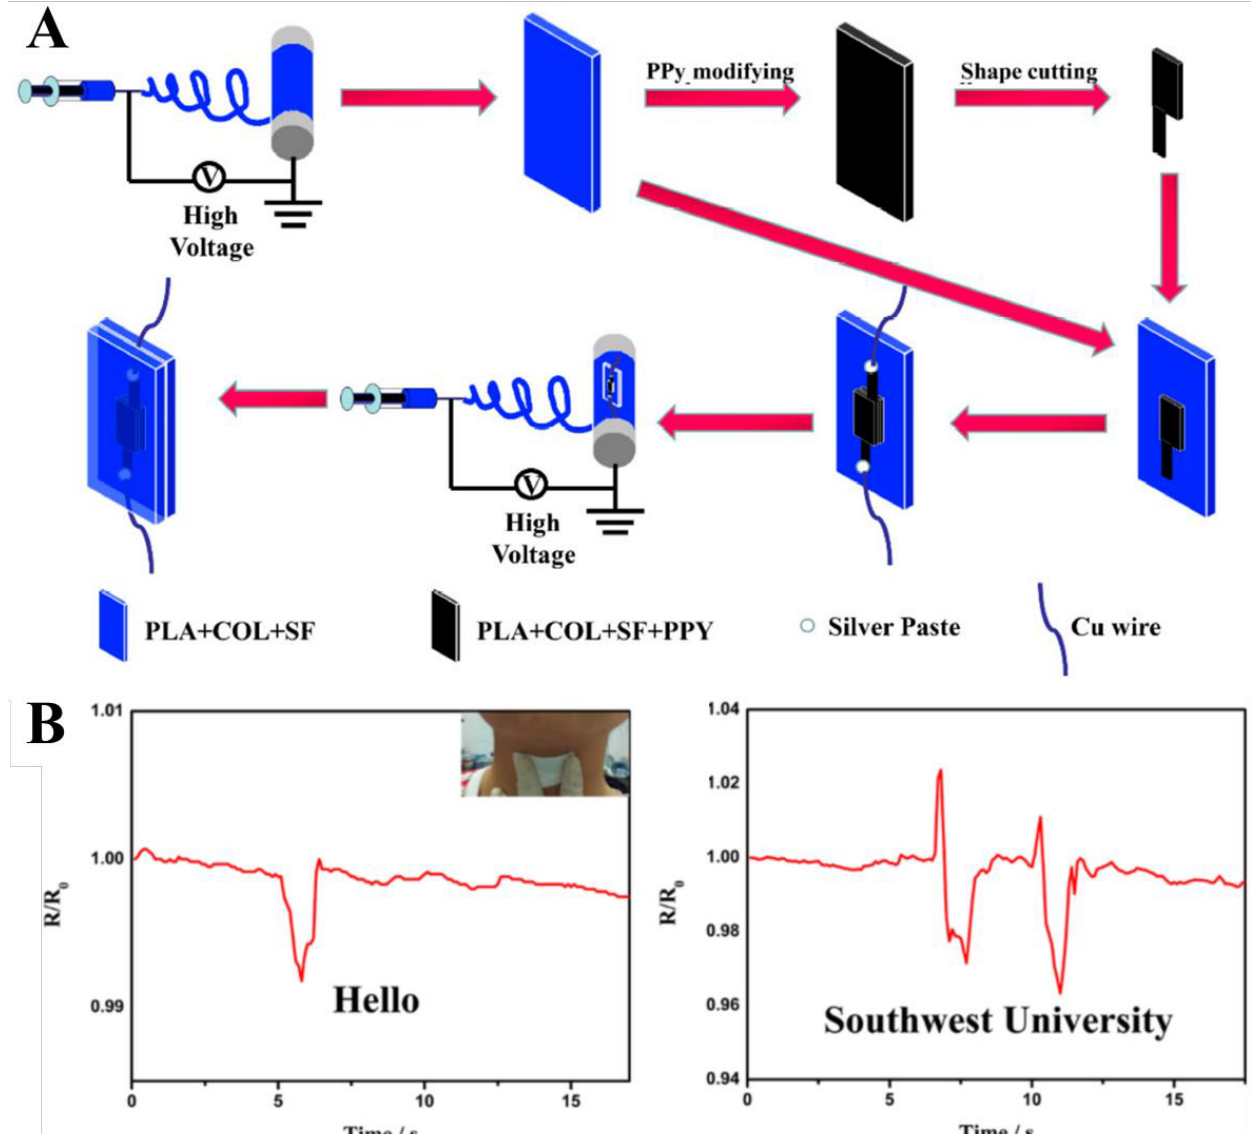
Figure 23. Human motions detectable by a piezoresistive sensing device composed of PPy-coated PLA/silk fibroin/collagen [268]: ( A ) fabrication via PPy coating of electrospun PLA/silk fibroin-collagen nanofibers; ( B ) vocal cord vibrations detected by a change in resistance in the sensor. Reprinted from [268], available at https://doi.org/10.3390/polym10060575, accessed on 1 December 2022